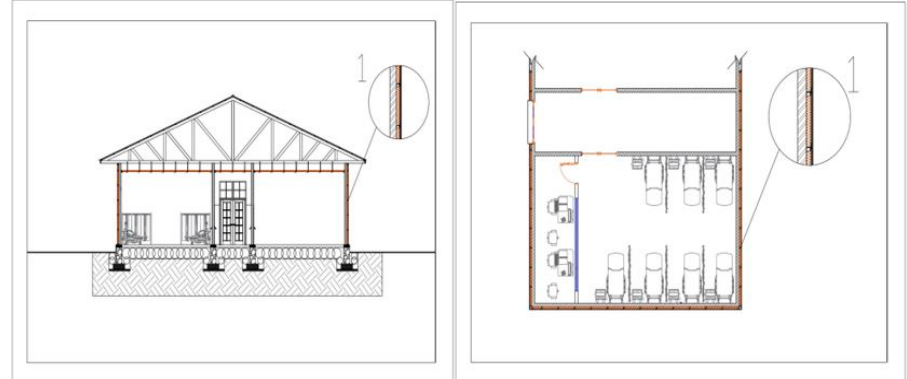
Figure 9. A sectioned front and plan view representation of the ICU building, showing external noise mitigation measures on the building wall.